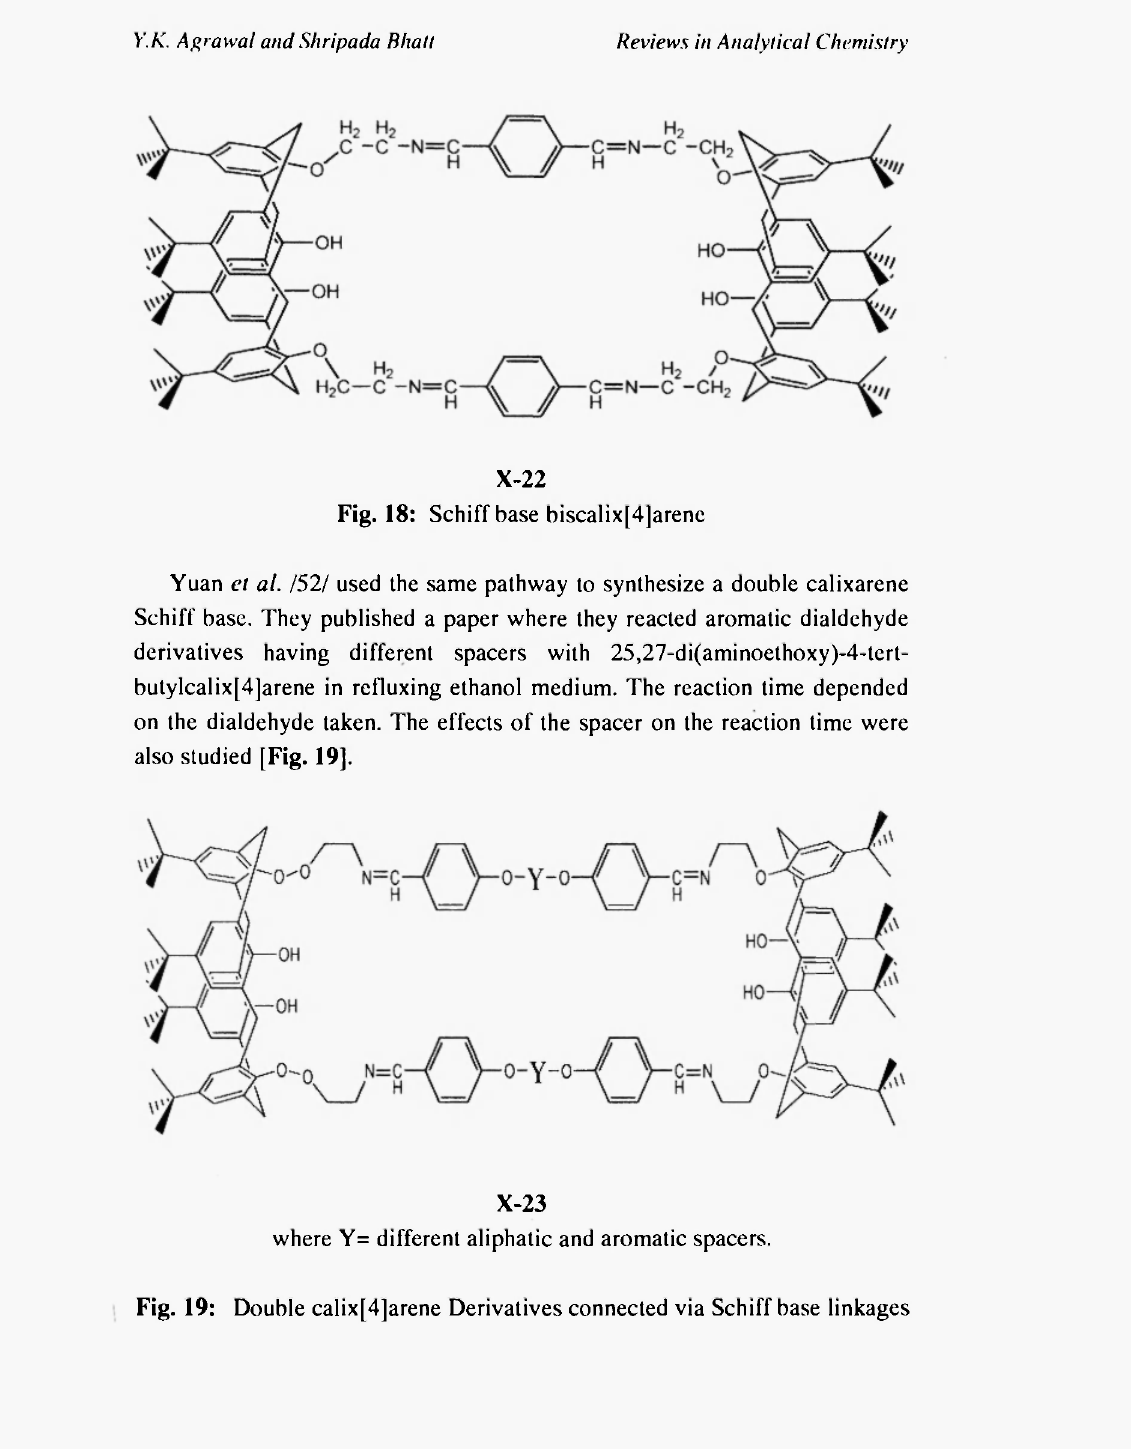
where Y= different aliphatic and aromatic spacers. Fig. 19: Double calix[4]arene Derivatives connected via Schiff base linkages